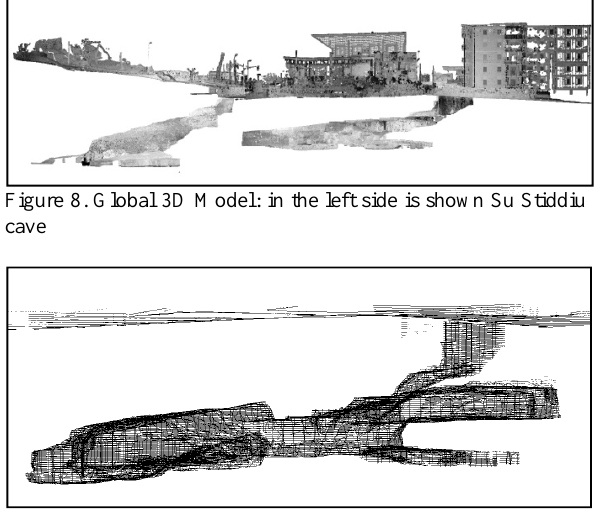
Figure 9. A wireframe of the void